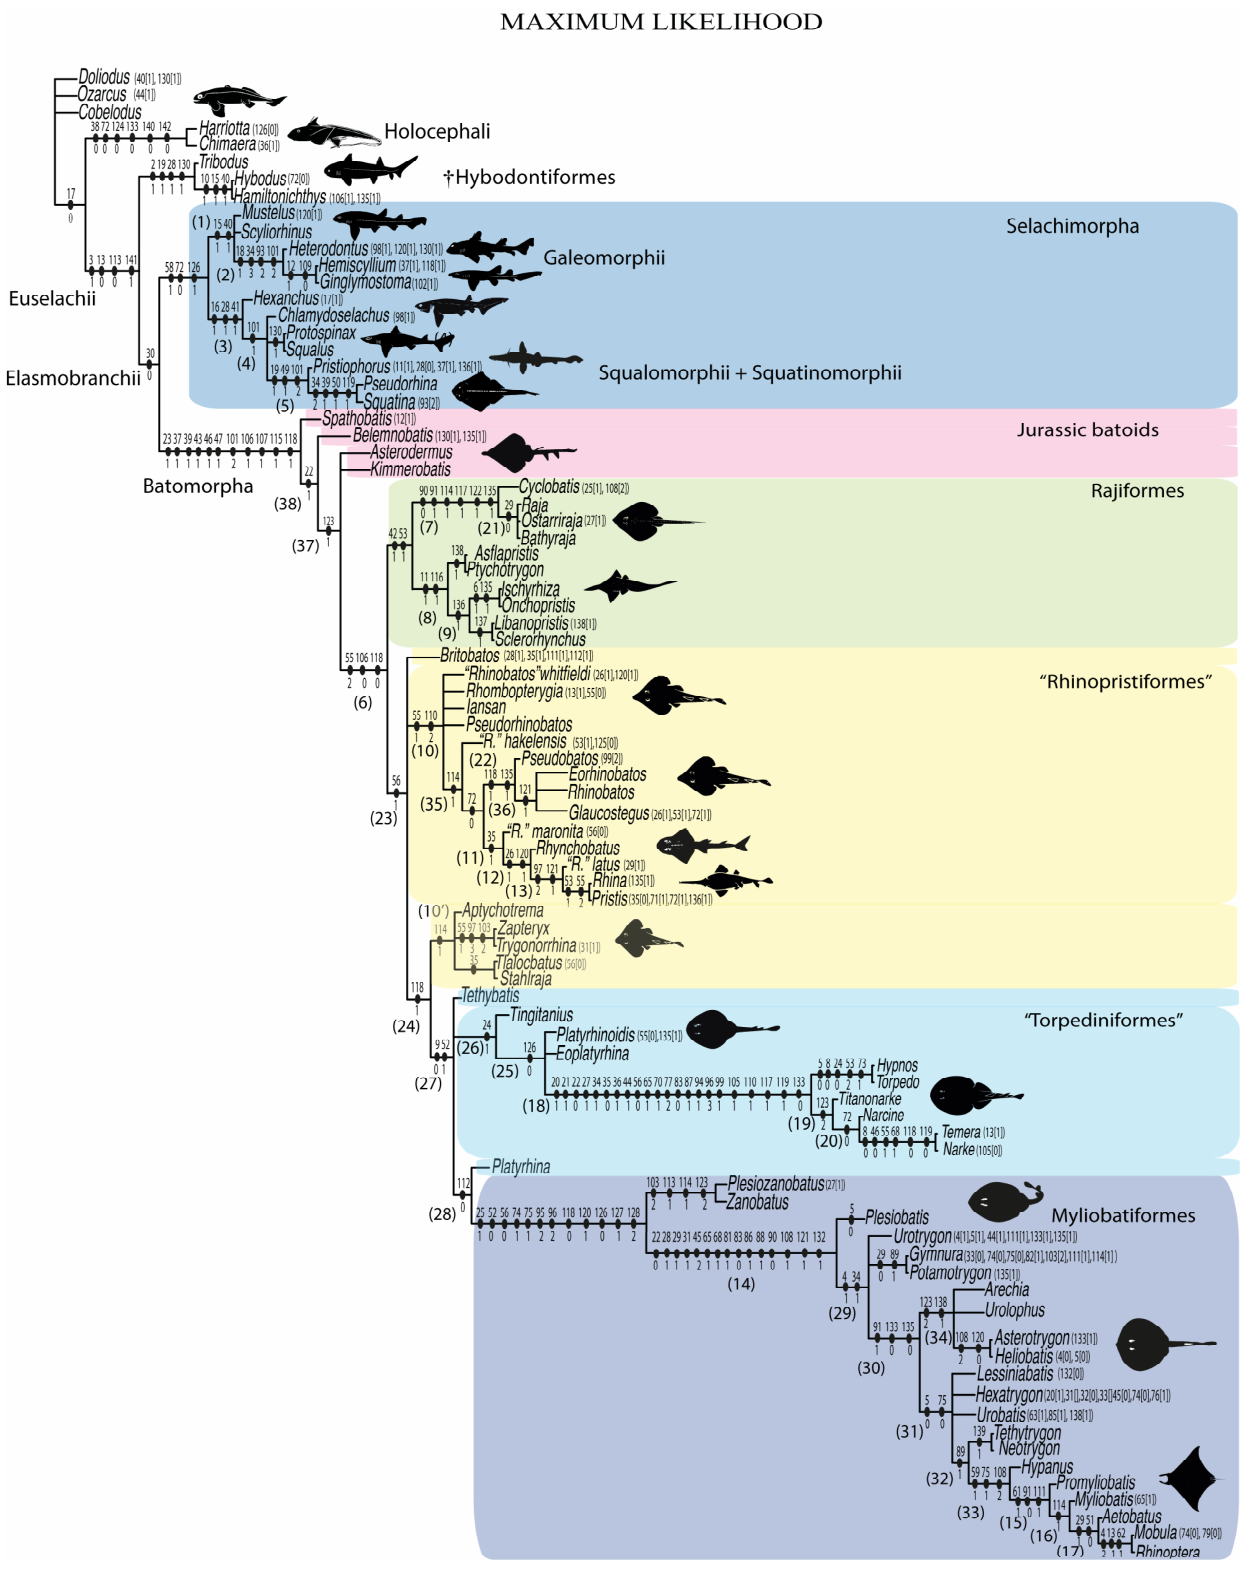
Figure 50. Strict consensus tree estimated from maximum-likelihood analysis in PAUP, after the selection of the trees with the best scores. For the full character list see the Supplemental Material. Clade numbers in